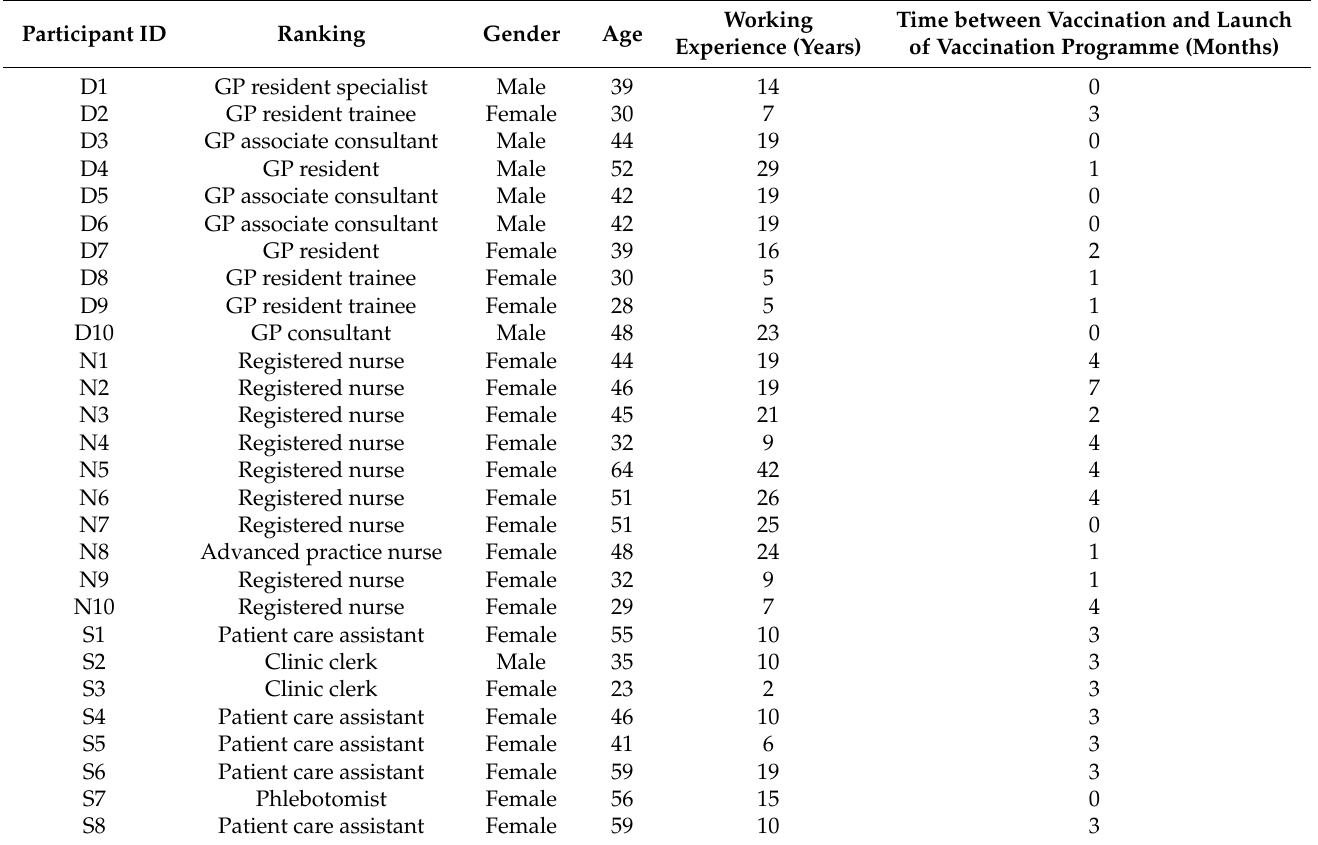
Table 2. Demographics of individual